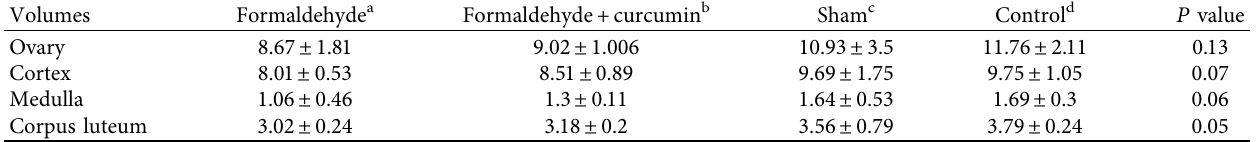
Table 3: Comparison of the volume of ovary, cortex, medulla, and corpus luteum among study